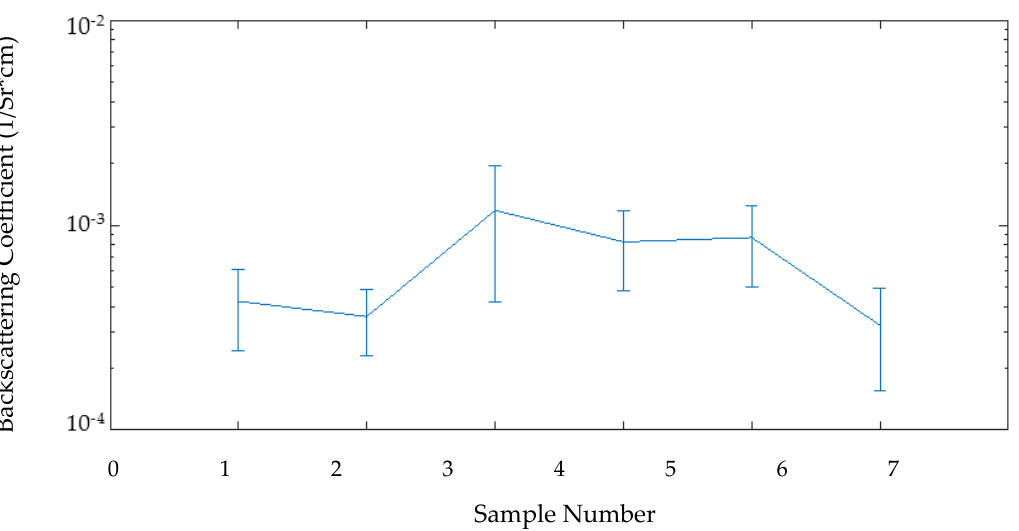
Figure 5. Backscattering coefficients for each digitally segmented tissue sample as a function of sample. Error bars show standard deviation across the full 30 mm of each scan.